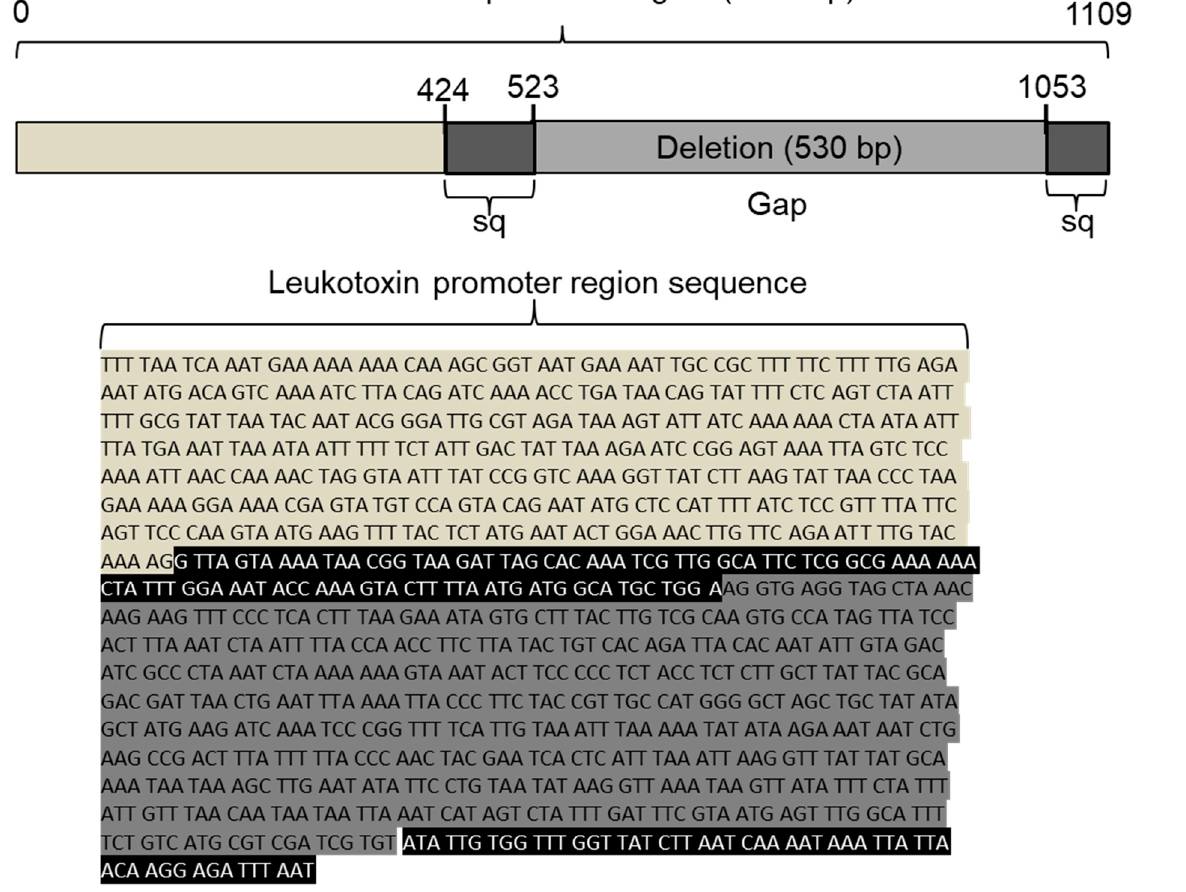
Figure 4. Schematic illustration of the leukotoxin promoter region. Extracted DNA from saliva of individuals positive for A. actinomycetemcomitans strains of serotype b was amplified by PCR using leukotoxin promoter-specific primers. The PCR products were visualized on an agarose gel, and one DNA band corresponding in size to that of the JP2 genotype was extracted from the gel and sent for DNA sequencing. The obtained sequence (highlighted in black) revealed the absence of the specific 530 base pair (bp) fragment (highlighted in dark gray), which is a specific characteristic of the JP2 genotype of A. actinomycetemcomitans .